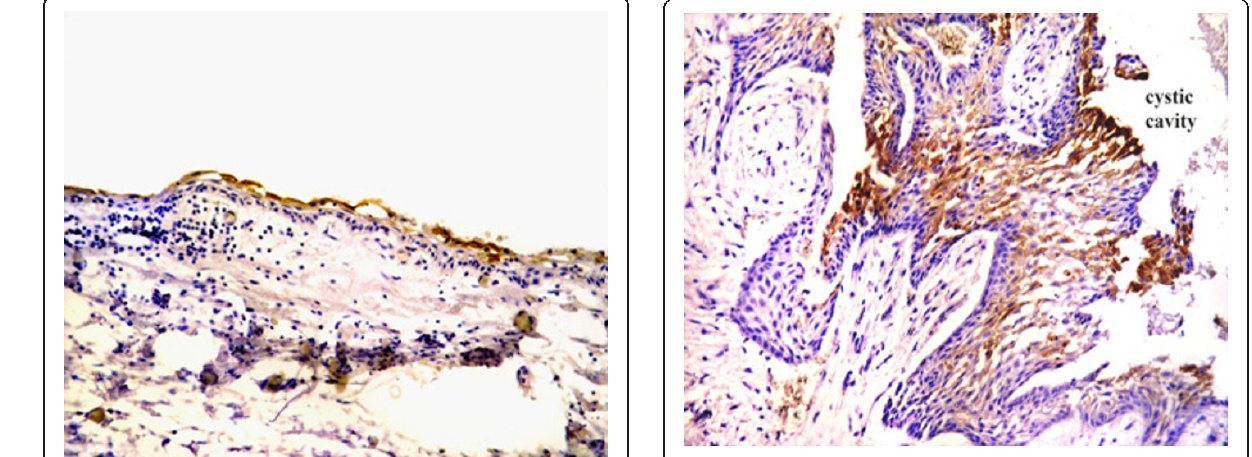
Figure 3 Photomicrograph of mural UCA showing cytoplasmic & membranous immunopositivity of stellate reticulum like cells while basal & suprabasal cells are immunonegative (Anti-CD10. Original magnification x40)